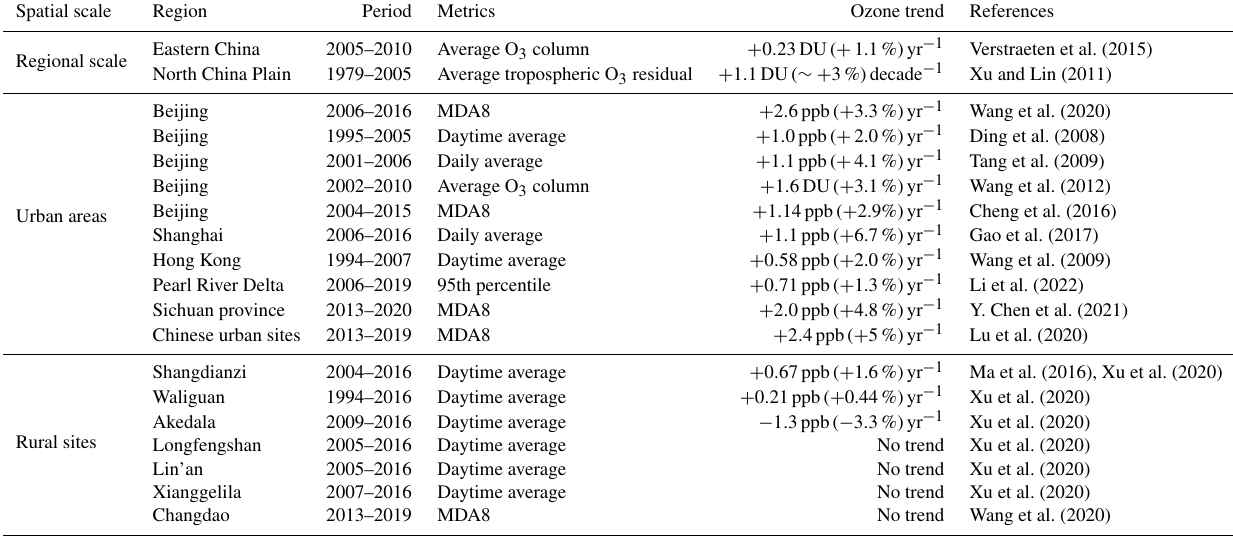
Table 1. The reported trends of ozone (O 3 ) concentration in